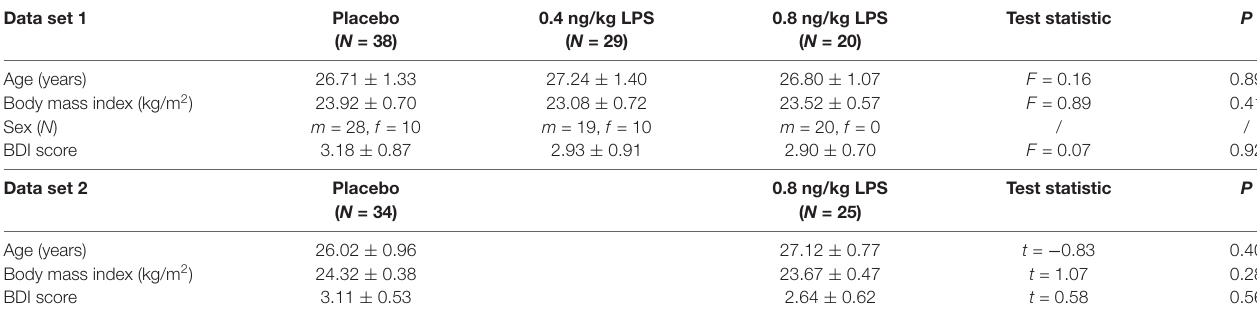
TABLE 1 | Sociodemographic and psychological characteristics for data set 1 (upper part) and data set 2 (lower